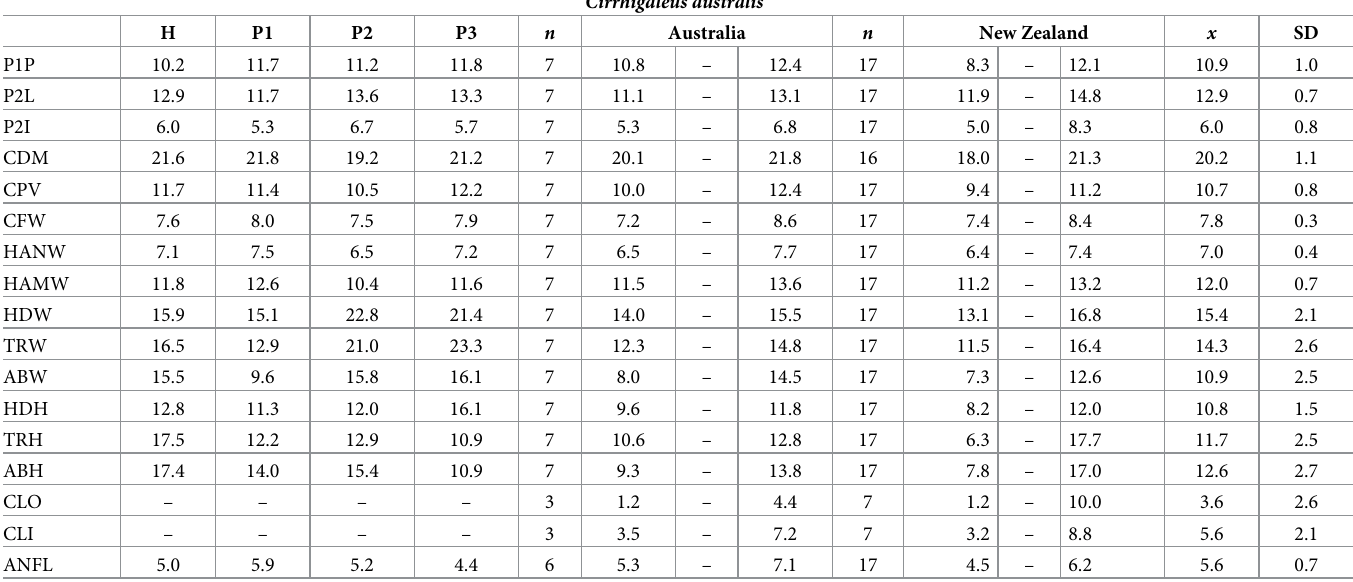
Short distance from mouth to snout tip, preoral length 7.3% (6.9%–8.6%) TL. Mouth strongly arched and wide, its width 1.9 (1.6–2.0) times prenarial length, and 2.2 (1.8–2.3) times broader than internarial space. Upper labial furrow markedly short, its length 0.9% (0.9%– 1.6%) TL, with thick fold; lower labial furrow elongate, lacking a fold. Teeth similar in both jaws, compressed labial-lingually, conspicuously broad and low (Fig 28); teeth of upper jaw much smaller than those of lower jaw; teeth unicuspid with cusp pointed, thin, cylindrical and short, directed laterally; mesial cutting edge somewhat convex, although diagonally; mesial and distal heels rounded; apron narrow and short, larger on lower teeth than upper teeth. Three series of functional teeth on both jaws; upper jaw with 12–12 (13–13) teeth rows; lower jaw with 10–10 (11–11) teeth rows. Dorsal fins conspicuously upright and vertical, both equally tall with first dorsal fin height 1.0 (0.9–1.2) times height of second dorsal fin; first dorsal fin as large as second dorsal fin, its length 1.0 (0.9–1.2) times length of second dorsal fin. Origin of first dorsal fin beyond vertical traced at the pectoral-fin free rear tips in adults. First dorsal fin markedly slender at fin web, apex rounded, and broad on its base, base length 8.4% (7.7%–9.8%) TL; first dorsal-fin anterior margin convex, raked and large, its length 12.2% (11.7%–14.6%) TL; first dorsal-fin posterior margin concave and elongate, its length 10.6% (9.0%–11.9%) TL; first dorsal-fin inner margin short, its length 6.3% (4.9%–6.8%) TL with pointed free rear tip; first dorsal fin height 1.6 (1.4– 2.0) times greater than first dorsal-fin inner margin length, and 1.5 (1.3–1.9) times preorbital length (Fig 29). First dorsal-fin spine straight, markedly elongate, although never reaching the fin apex, its length 5.7% (3.1%–6.8%) TL, corresponding to two-fourth the height of first dorsal fin. Interdorsal distance 1.2 (1.0–1.3) times pre-pectoral length, and 3.0 (2.3–3.5) times greater than dorsal-caudal space. Origin of second dorsal fin posterior to vertical traced at pelvic-fin free rear tips. Second dorsal fin slender at the fin web, apex rounded and lobulate, broad at its base, base length